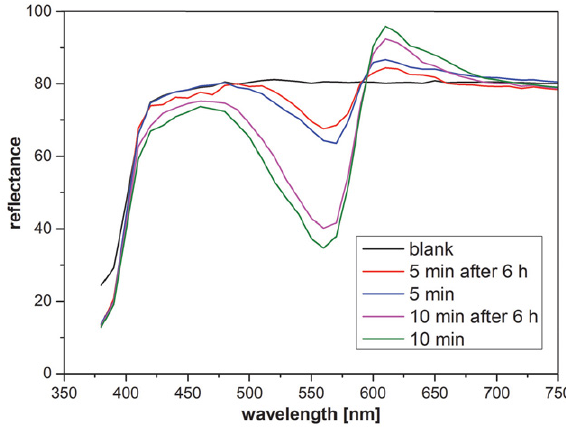
Figure 6: The colouring of the detection film after the diphosgene vapour exposure at the concentration of 1 mg/m 3 and 5, 10 min ex- posure is presented. The sample set was placed in uncontaminated environment for 6 h and subsequently exposed to the correspond- ing analyte